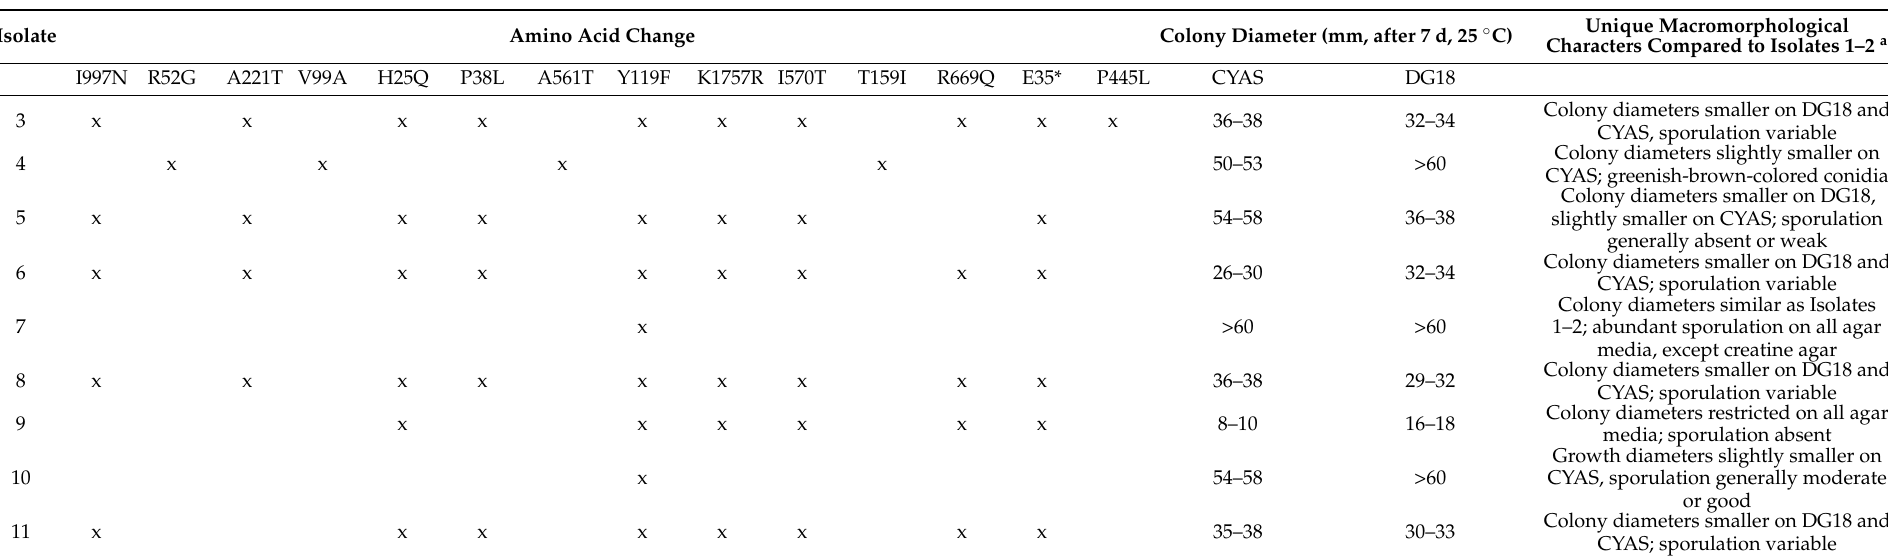
Table A2. Overview of the amino acid changes of nine A. flavus isolates and the unique macromorphological